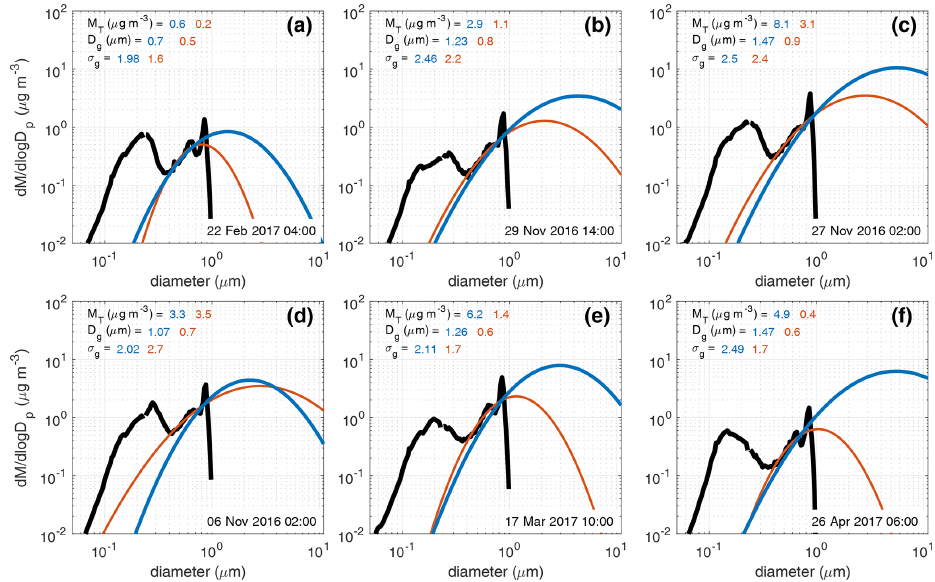
Figure 10. Selected characteristic fits to the sea spray mode. UHSAS mass size distribution (black), UHSAS-NEPH (blue), and UHSAS-only (orange). Panels are oriented to reflect increasing mass, size, and width of the sea spray mode retrieved by UHSAS-NEPH from left to right (a–c, d–f) . Mode fitting parameters – total mode mass ( M T ) , geometric mass mean diameter ( D g ) , and geometric standard deviation ( σ g ) – for the UHSAS-NEPH and UHSAS-only methods are identified in text above the plots in each panel and colored by the retrieval method. 2h average time stamps are provided at the lower